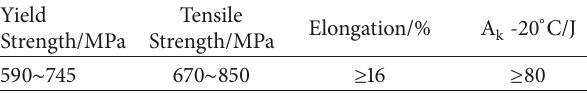
Table 4: Mechanical properties of 10CrNi3MoV